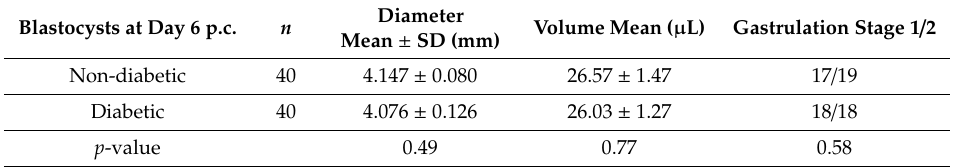
Table 7. Parameters of blastocysts used for the metabolic analyses in blastocoel fluid by Metabolon ® . Blastocysts at Day 6